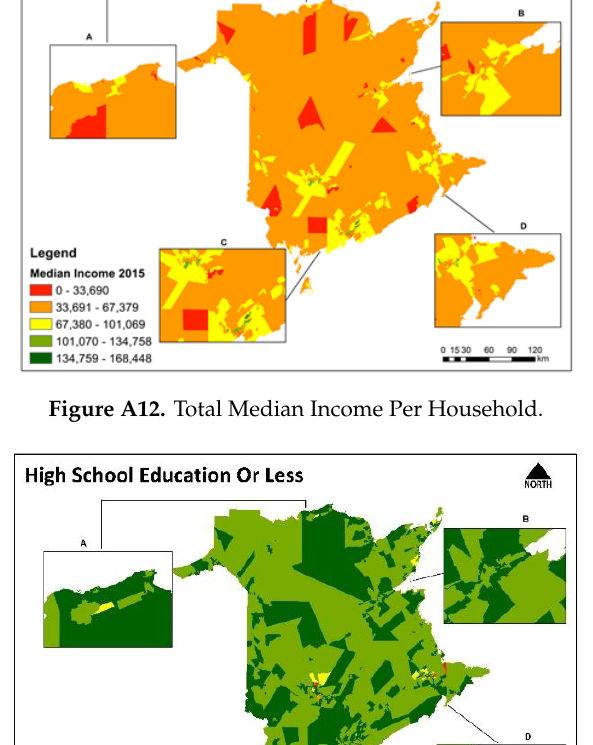
Figure A11. Children Below 5 Years Old.